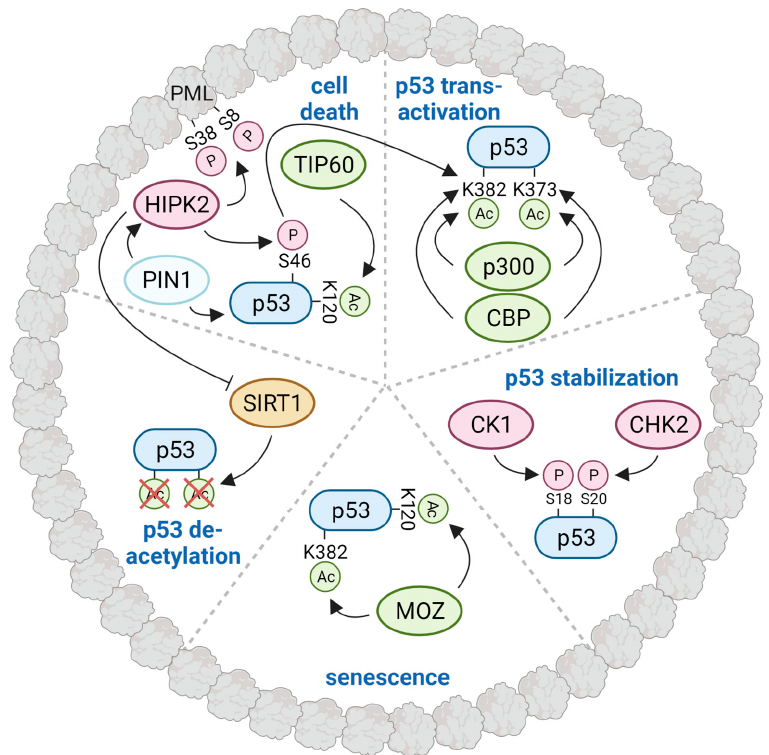
Figure 3. Control of p53 post-translational modifications and p53 activity at PML biocondensates. Schematic representation of a mature PML NB, in which PML resides at the peripheral shell. Phos- phorylation of p53 at S18 and S20 by the kinases CK1 δ / ε and CHK2, respectively, is involved in p53 stabilization. Acetylation of p53 at K373/K382 by the acetyltransferases p300 and CBP results in